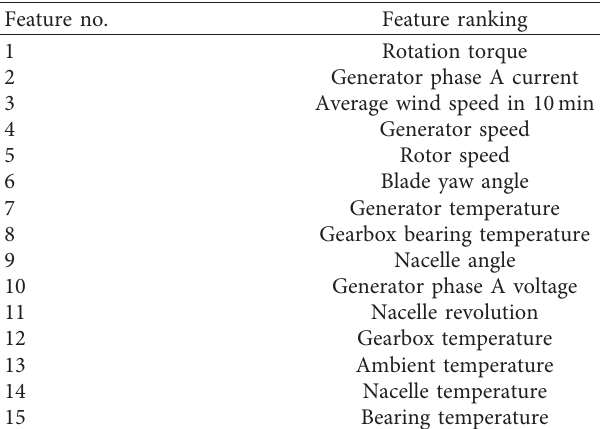
Table 2: Feature selection result based on